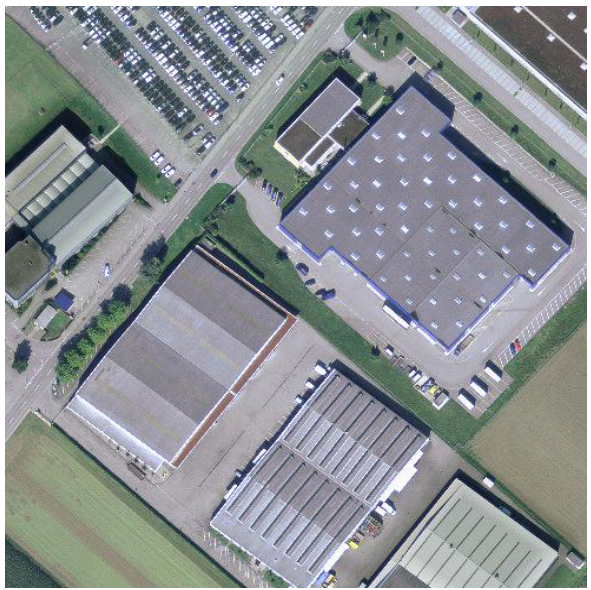
Figure 2. Orthophoto of the industrial neighbourhood of Oensingen, (© swisstopo, 2006).